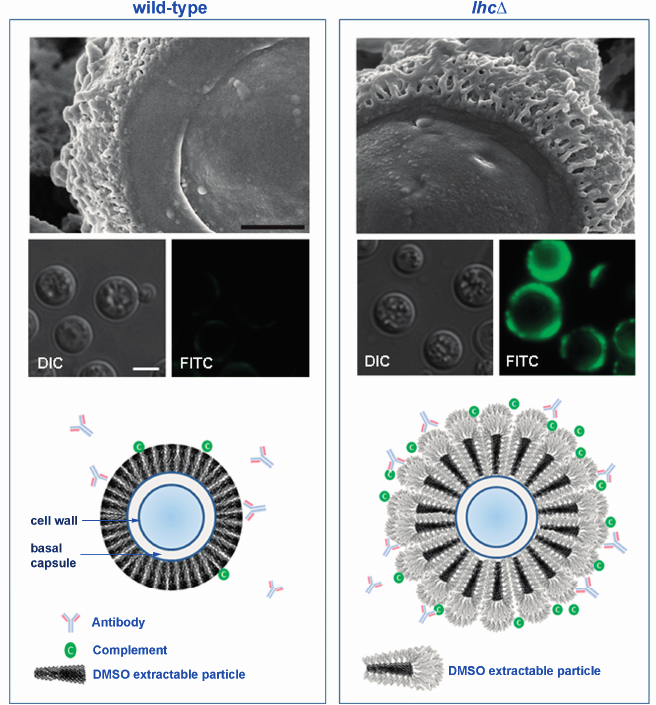
Figure 2. Wild-type and lhc1 Δ mutant strains of C. neoformans differ in capsule and antibody binding. Upper panel : Three dimensional ultrastructure of C. neoformans